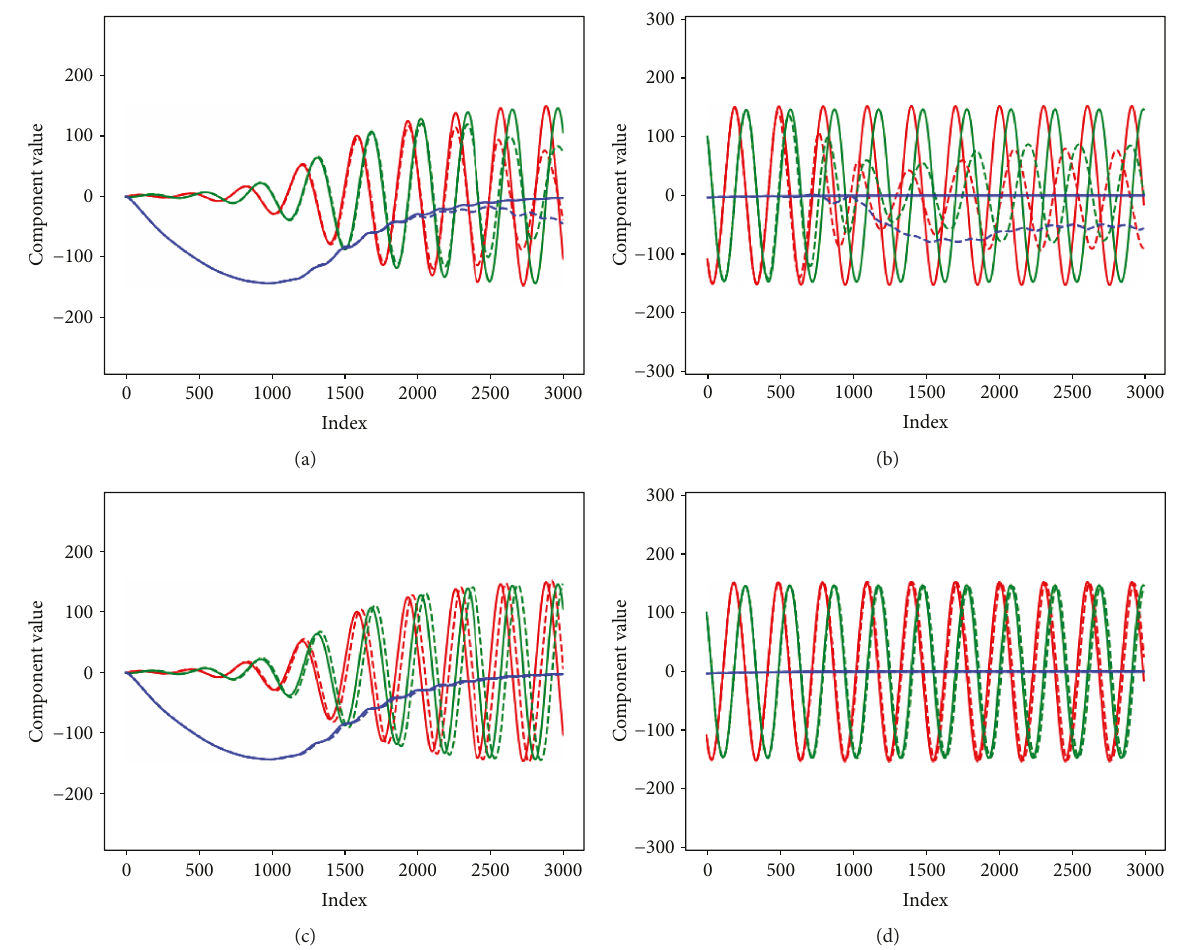
Figure 15: A posteriori comparison between basic and regularized models for cylinder wake. Red: fi rst POD coe ffi cient. Green: second POD coe ffi cient. Blue: shift-mode coe ffi cient. (a, b) Basic model. (c, d) Regularized model. (a, c) Training data. (b, d) Testing